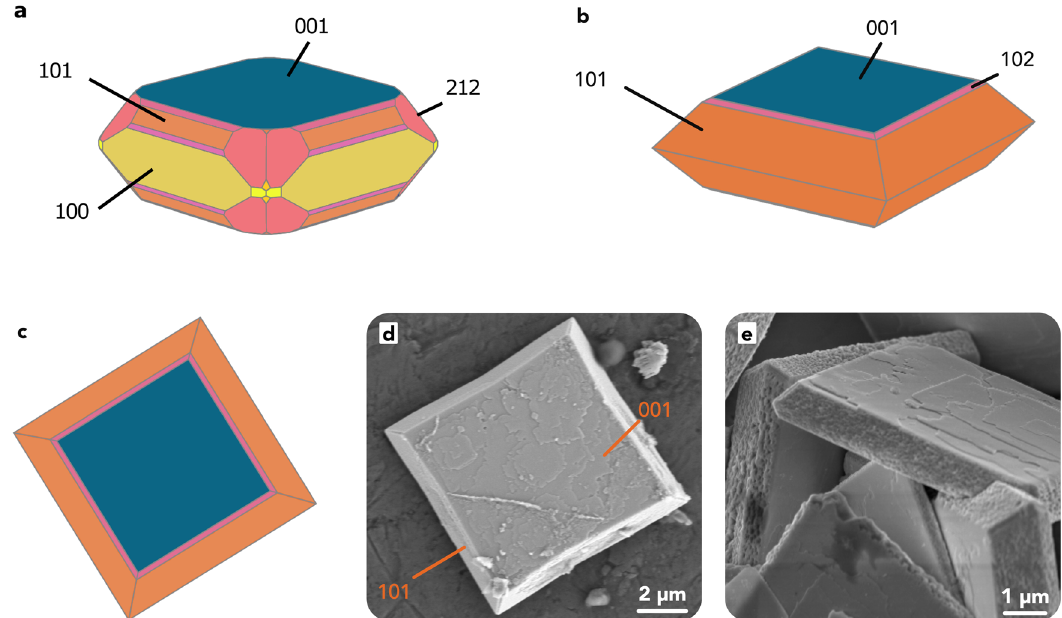
Fig. 5 Theoretically predicted SnO nanoparticle shape. a Wulff equilibrium crystal shape including all low-index surfaces, b , c crystal shape only allowing crystal faces with surface energies less than 0.6Jm − 2 , d , e SEM micrographs of experimentally synthesized platelets in water.